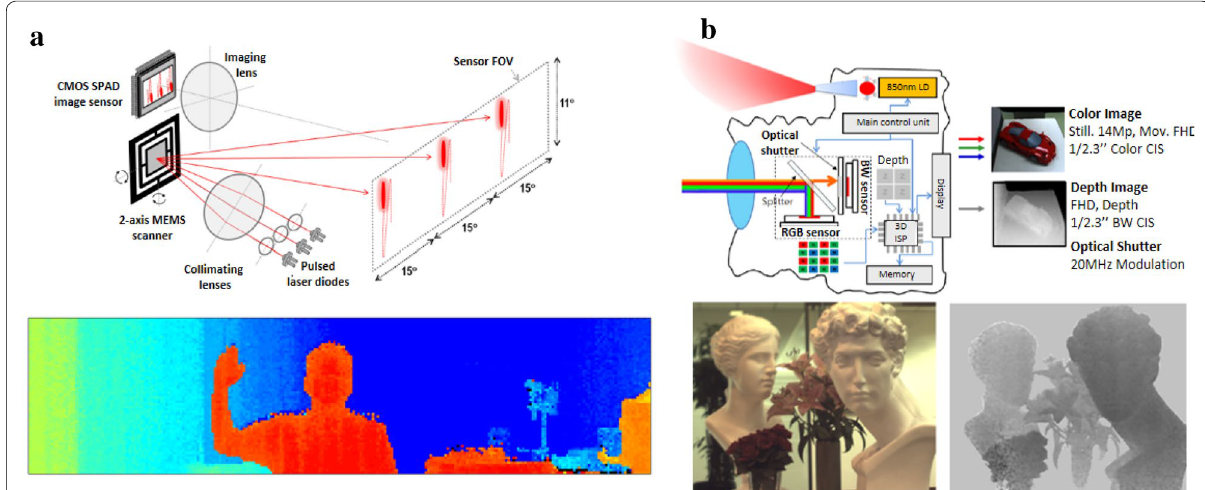
Fig. 5 ToF based 3D surface imaging systems; a 254 64‑pixel single photon CMOS sensor with two‑axis scanning MEMS mirror and their × measured depth image of 3D scene [39]. b Micromachined electro‑absorptive optical modulator for ToF based 3D imaging and the depth map of 3D objects acquired using the ToF system [18, 40,